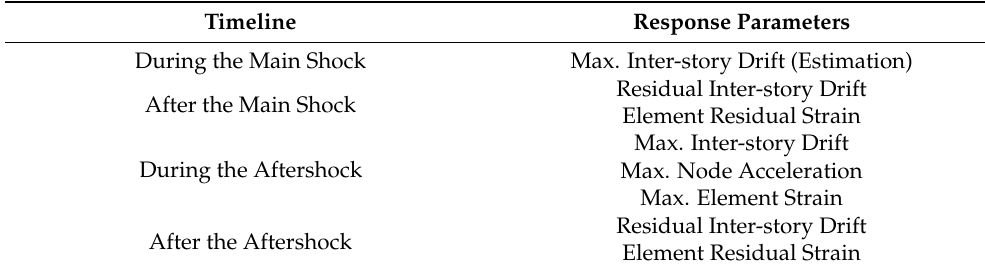
Table 3. Structural response parameters at different